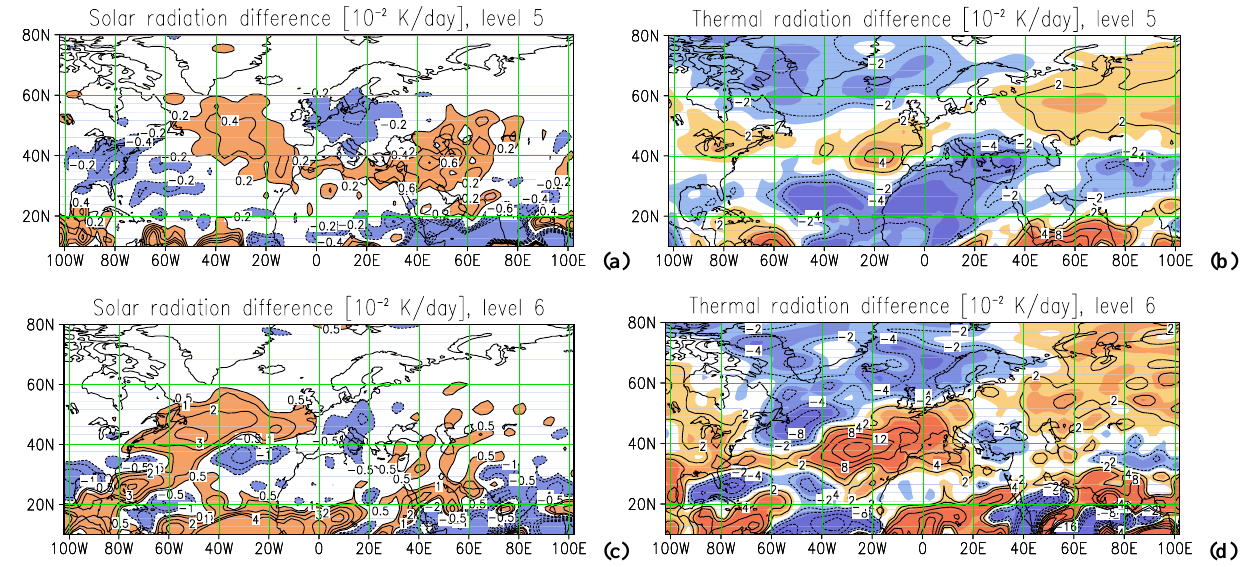
Fig. 10. Ozone anomaly forcing with feedbacks. Mean January forcing difference due to ozone anomaly including dynamical feedbacks (positive values light shaded, negative values dark shaded). (a) For solar radiation at level 5 (near 100 hPa), (b) For thermal radiation same level as (a), (c) For solar radiation at level 6 (near 150 hPa), (d) For thermal radiation same level as